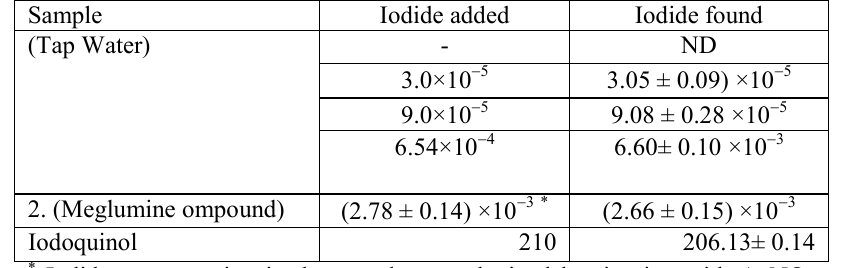
Table 4. Determination of iodide in tap water and